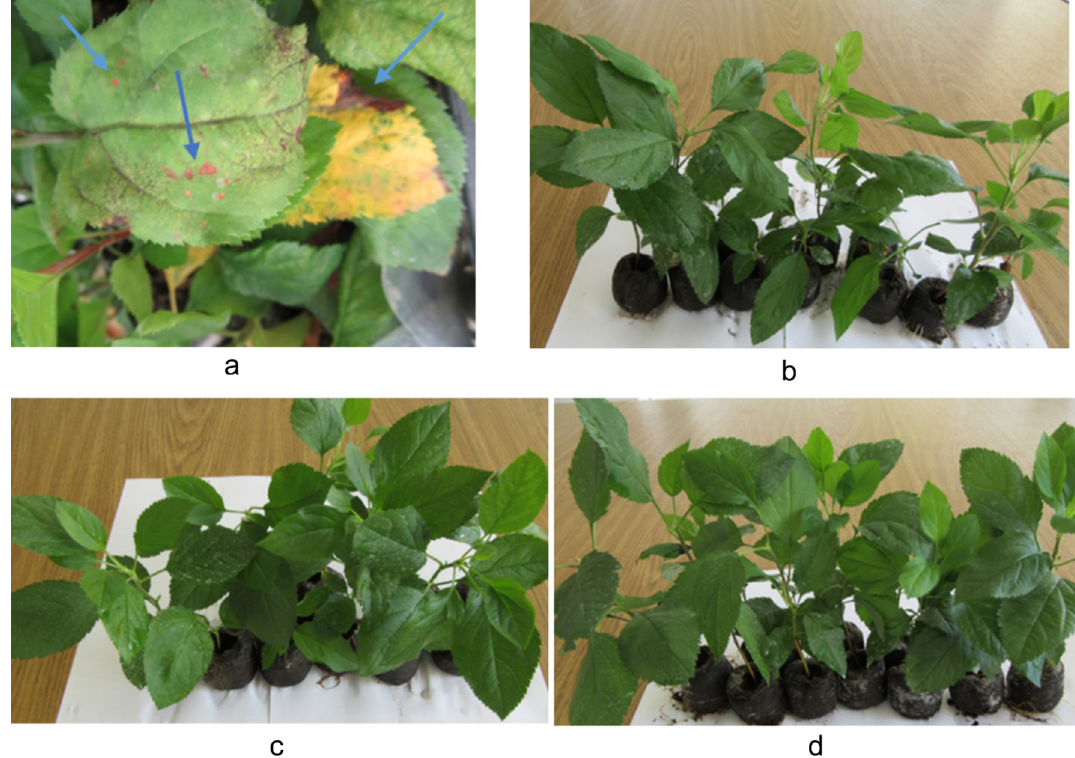
Figure 8. Effect of the tested materials for the control of apple scab— Venturia inaequalis : ( a )—untreated (negative) control;